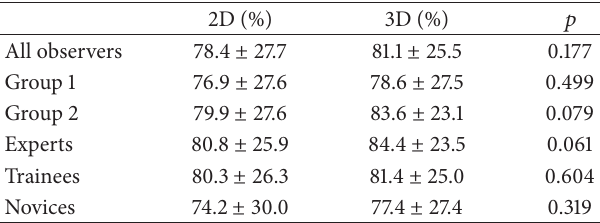
Table 1: Average accuracy in determining the extent of